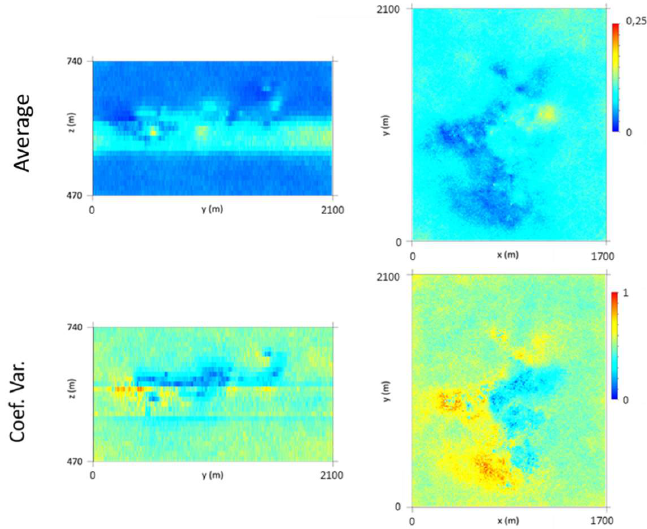
Figure 15. Results for the final model of wolframite quantity (in kg/m 3 ) (average and coefficient of variation): Px81 (left) and Pz75 (right).